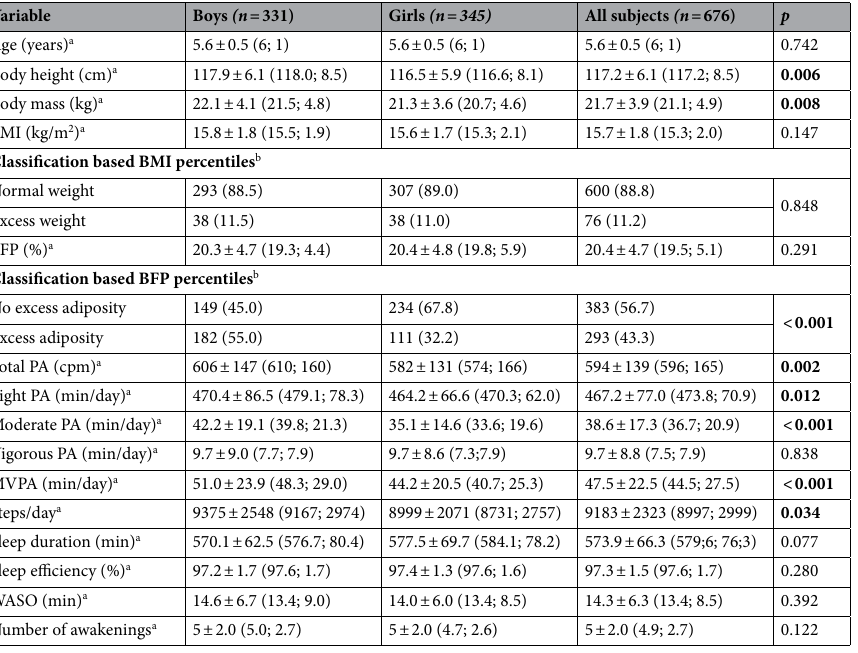
Table 1. General characteristics of the study population. Data are expressed as: a mean ± SD (median; IQR); b n (%); p value represents the differences between boys and girls. BFP body fat percentage, BMI body mass index, MVPA moderate to vigorous physical activity, PA physical activity, WASO wake after sleep onset; significant associations are highlighted in bold. Activity levels were determined based on triaxial 24 h-accelerometry vector magnitude, defining 101–2295 cpm as light PA, 2296–4011 cpm as moderate PA, ≥ 4012 cpm as vigorous PA and ≥ 2296 cpm as MVPA 29 . Excess weight was defined as BMI ≥ 85th percentile; normal weight was defined as BMI < 85th percentile 33 . Excess adiposity was defined as BFP ≥ 85th percentile; no excess adiposity was defined as BMI < 85th percentile 37